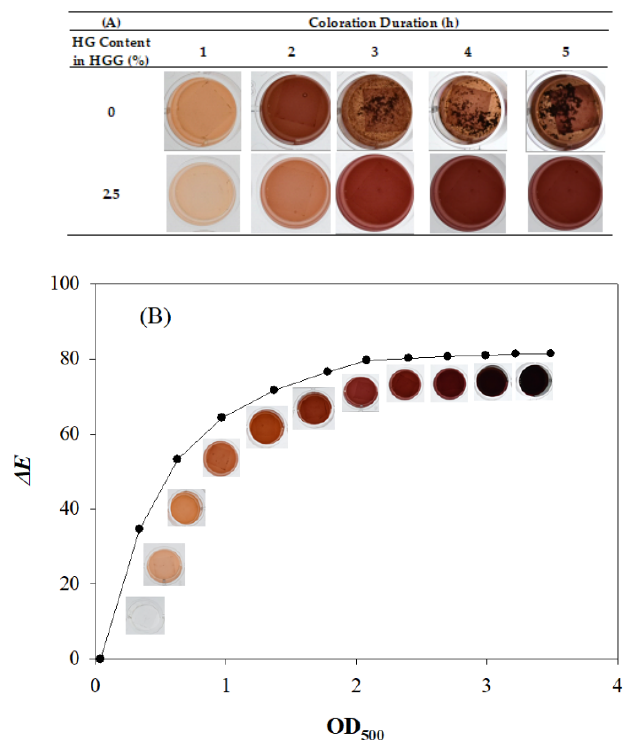
Figure 2. ( A ) Color change of guaiacol solution with and without 2.5% hydrolyzed gelatin (HGG)